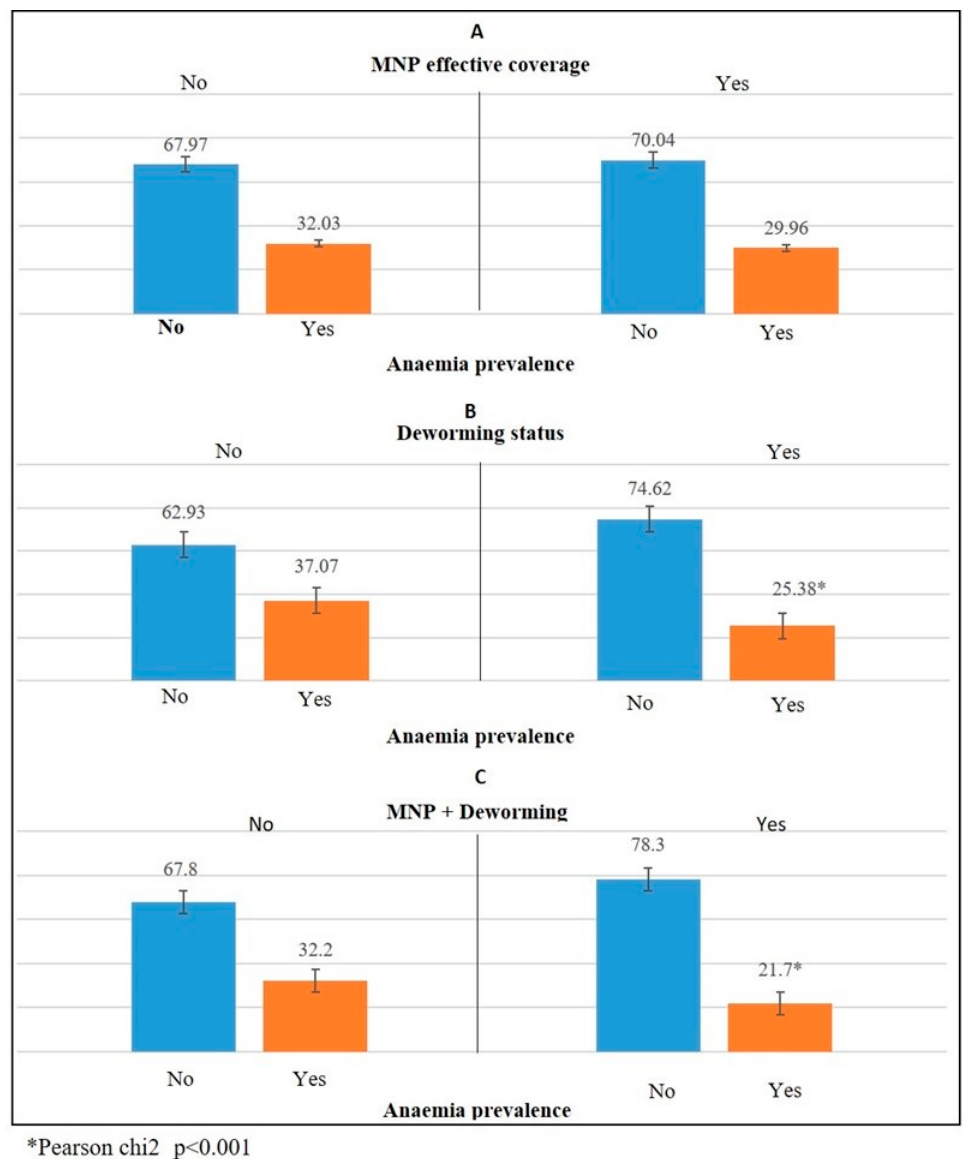
Figure 1. Distribution of anaemia prevalence by deworming status and MNP coverage among chil- dren aged 6–59 months. ( A ) MNP effective coverage; ( B ) Deworming status; ( C ) MNP + Deworming. The unadjusted model (Table 3) revealed significant associations between several independent variables and anaemia prevalence. The age of the children, caregivers, and fathers were all significantly associated ( p < 0.001) with the prevalence of anaemia (i.e., as the child’s age increased, the prevalence of anaemia decreased significantly). For example, the anaemia prevalence decreased by 4% if the child’s age increased by one month (OR 0.96; 95%CI 0.957, 0.964; p < 0.001). Fathers and caregivers with five and more years of schooling were less likely to have anaemic children than illiterate parents and parents with less than five years of schooling. The children in households in the middle or wealthier categories in the household wealth index were significantly less likely to be anaemic than the children in households in the poor household category. Similar associations were observed when children participated from the A&T and Nutrition programme platforms. In terms of survey timepoints, children who participated in survey-2 and survey-3 were significantly more likely to be anaemic than were children who participated in survey-1 (Table